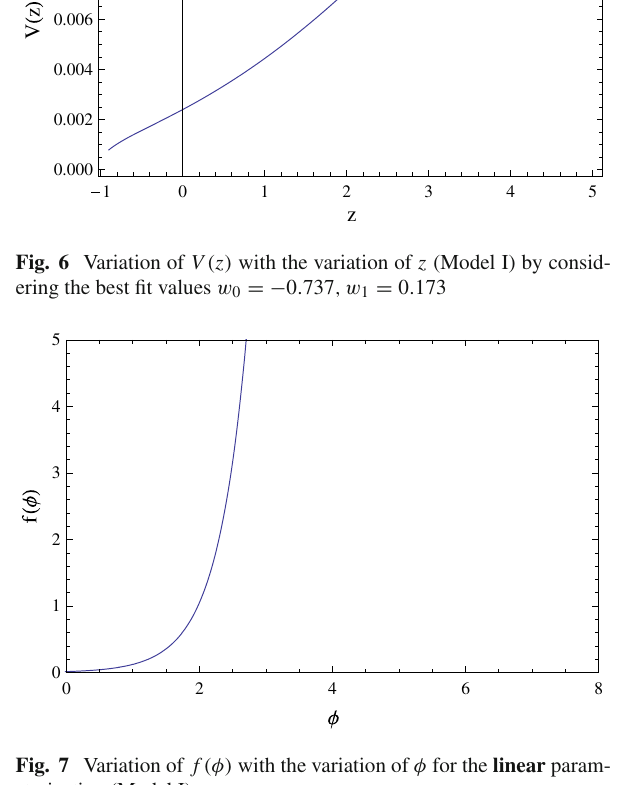
Fig. 7 Variation of f (φ) with the variation of φ for the linear param- eterization (Model I)